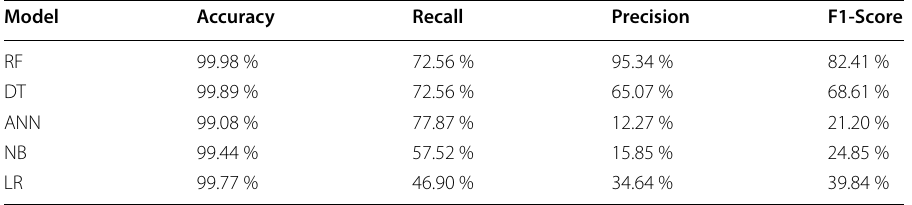
Table 6 Classification results for v 5